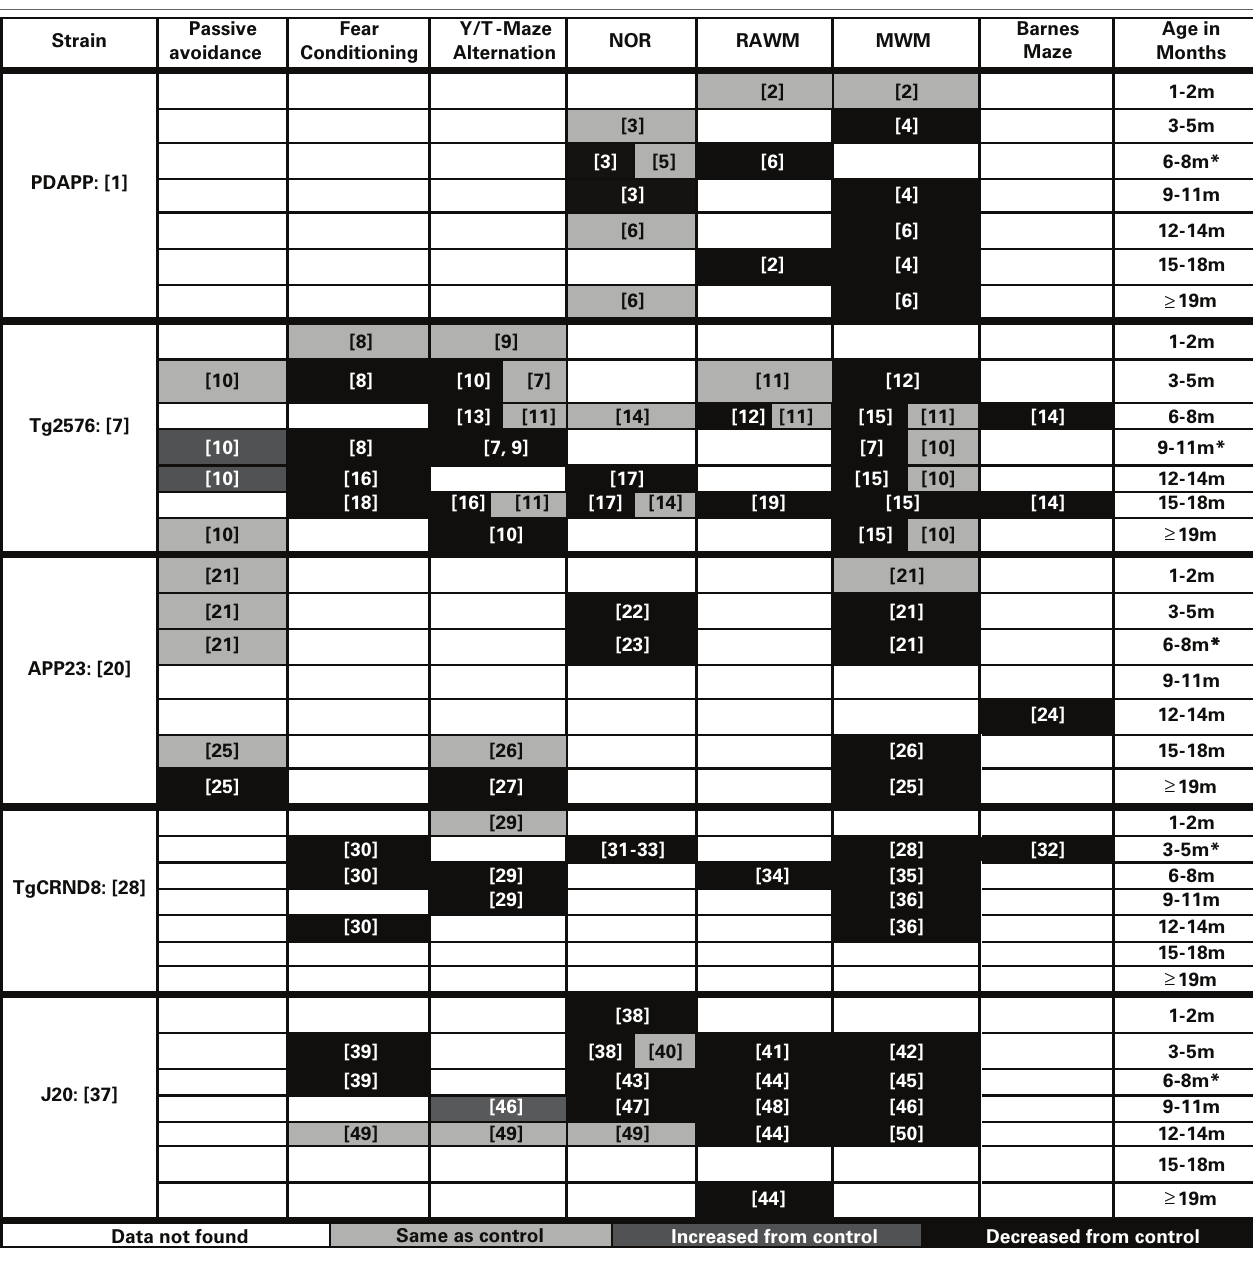
≥ Same as control Increased from control Decreased from control The strain is presented in the left column and age is presented in the right column. Black cells represent impairment, light gray cells represent no impairment compared to controls, dark gray cells represent increases from control (very few such cases), and white cells represent time points where no data are available for the respective behavior. The asterisk appearing in the age column represents when diffuse amyloid plaques are first observable in the brain for that particular mouse model of AD. The numbers within each cell correspond to the following references: 1: (Games et al., 1995), 2: (Nilsson et al., 2004), 3: (Dodart et al.,